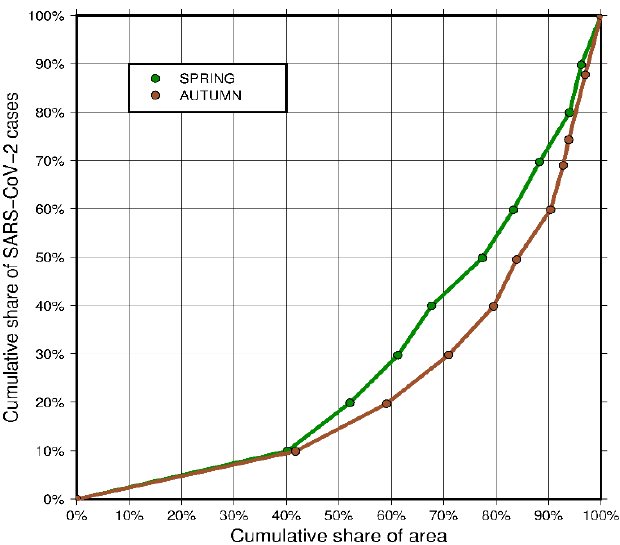
Figure 5. Lorenz concentration curve (source: own work).